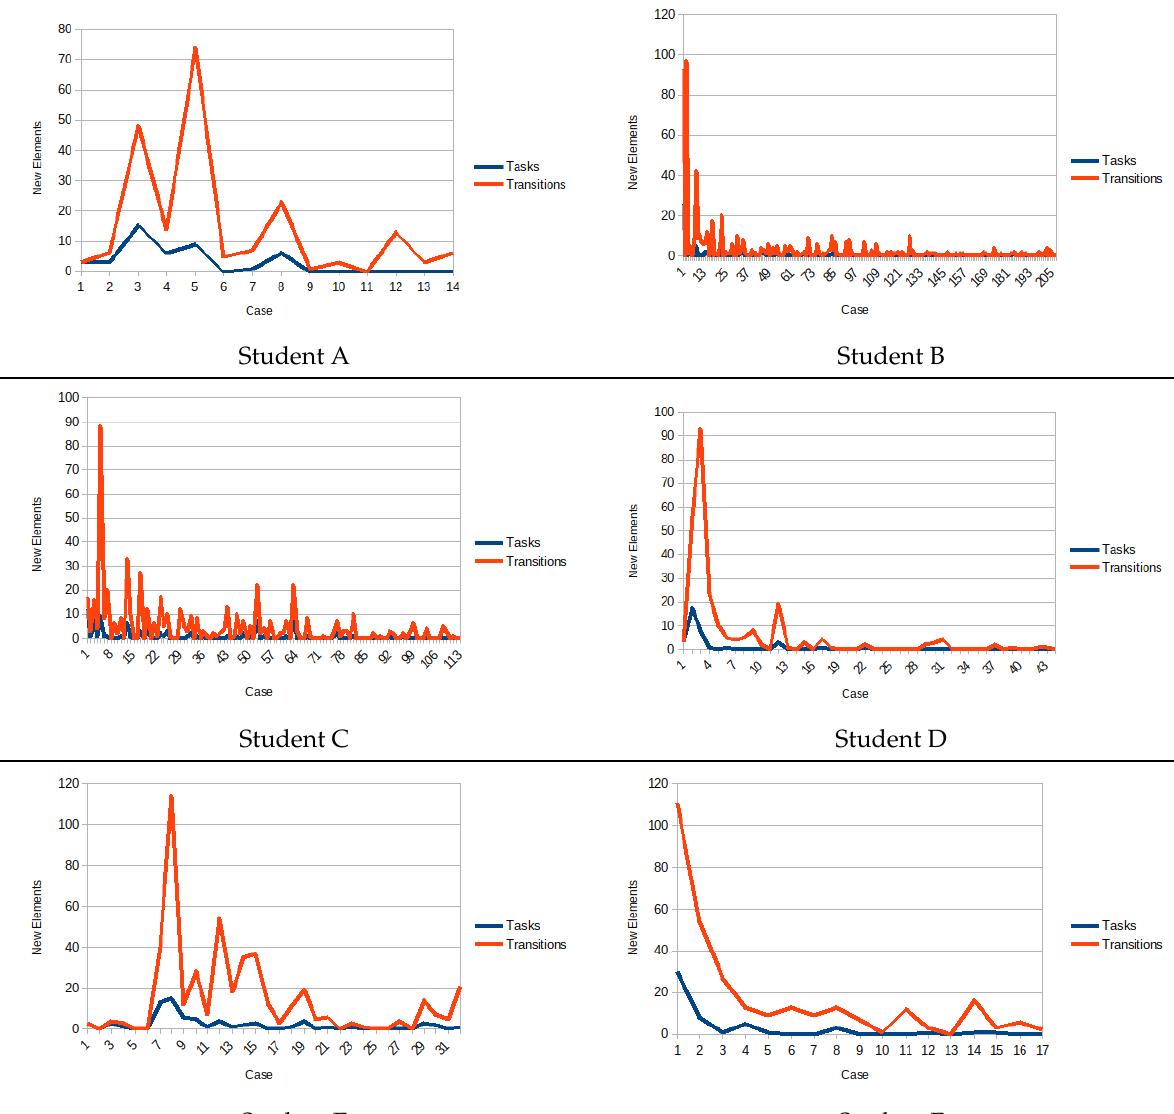
Figure 2. Trend in incremental prequential process model learning for different